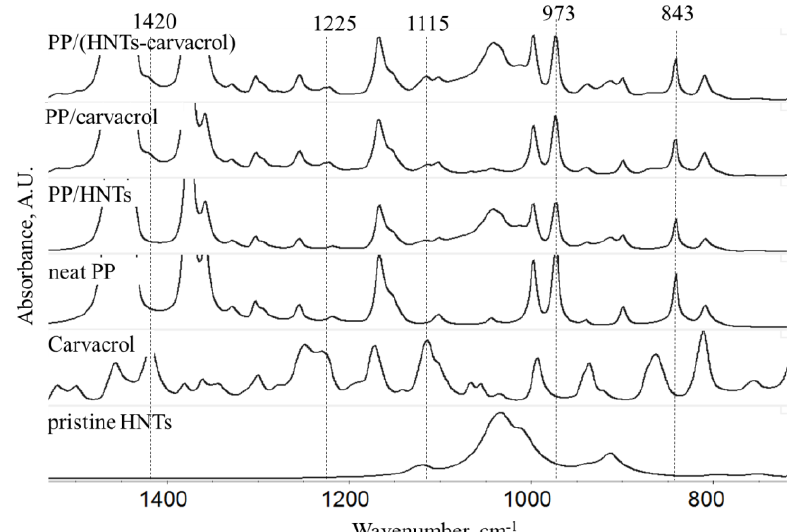
Figure 2. Fourier-transform infrared (FTIR) spectra (transmission mode) of neat PP, PP/HNTs, PP/carvacrol and PP/(HNTs-carvacrol) films, presenting the 1800–700 cm −1 region. Spectra of pristine HNTs and carvacrol are also included for comparison. The spectra of the PP/carvacrol and PP/(HNTs-carvacrol) films suggest homogeneous distribution of the carvacrol within the PP matrix. Peaks at 973 cm −1 and 841 cm −1 were used for estimation of the crystallinity in the PP films. Note that the spectrum of carvacrol is presented on a smaller absorbance scale, for clarity.